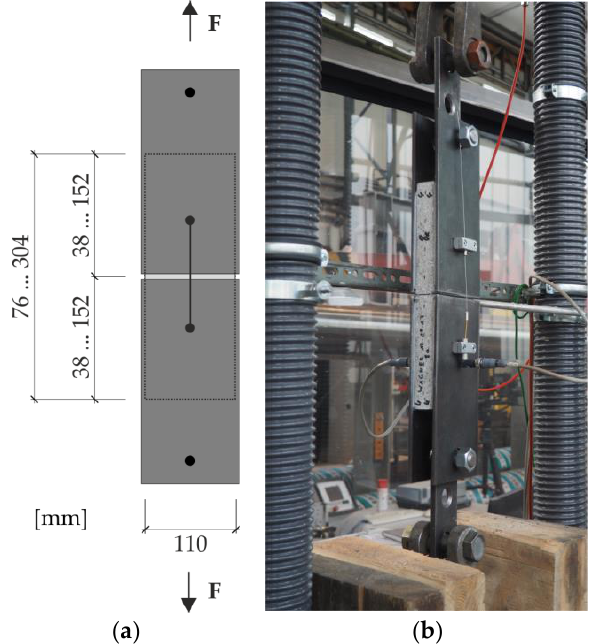
Figure 3. Test setup for static and cyclic double-sided textile pull-out (DPO) tests: ( a ) Specimen geometry; ( b ) Testing machine with specimen.